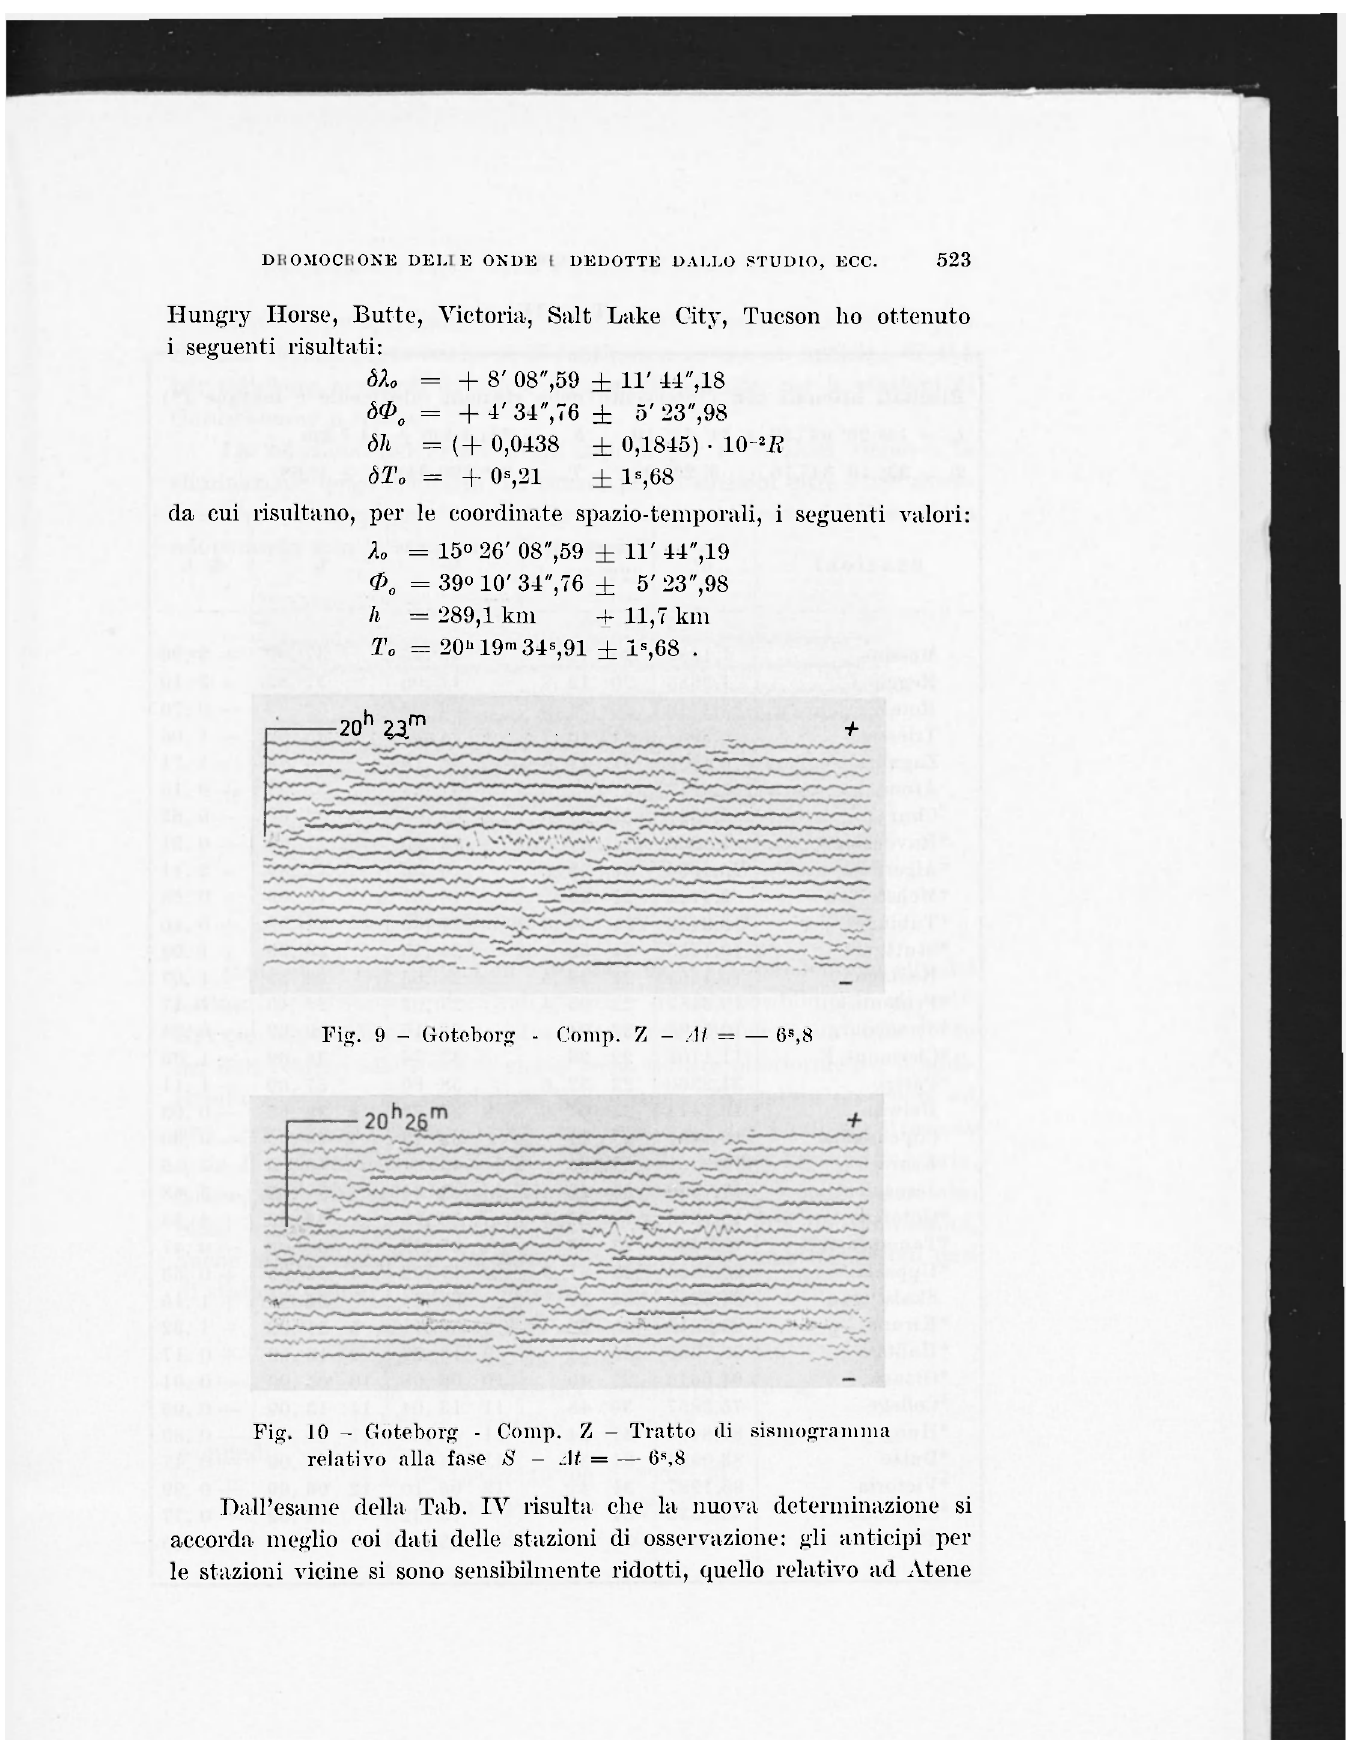
Fig. 10 - Goteborg - Comp. Z - Tratto di sismogramma relativo alla fase S - At = — 6 S